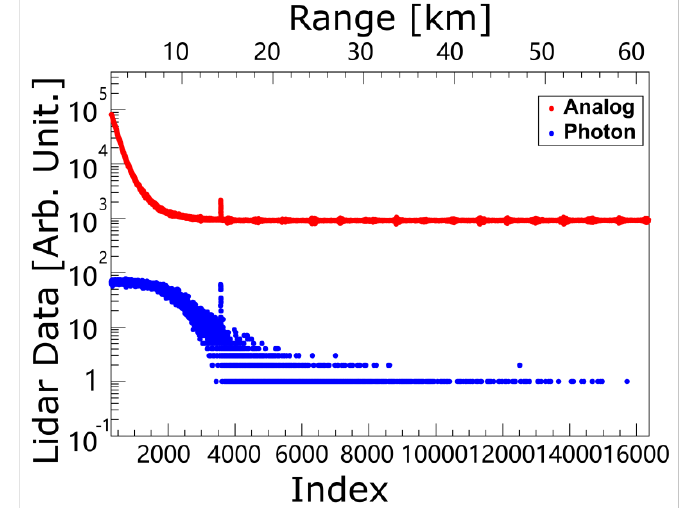
Figure 2. A typical lidar profile with a summed result of 20 laser shots from the ultraviolet elastic scanning lidar with simultaneous analog detection mode and photon-counting detection mode.